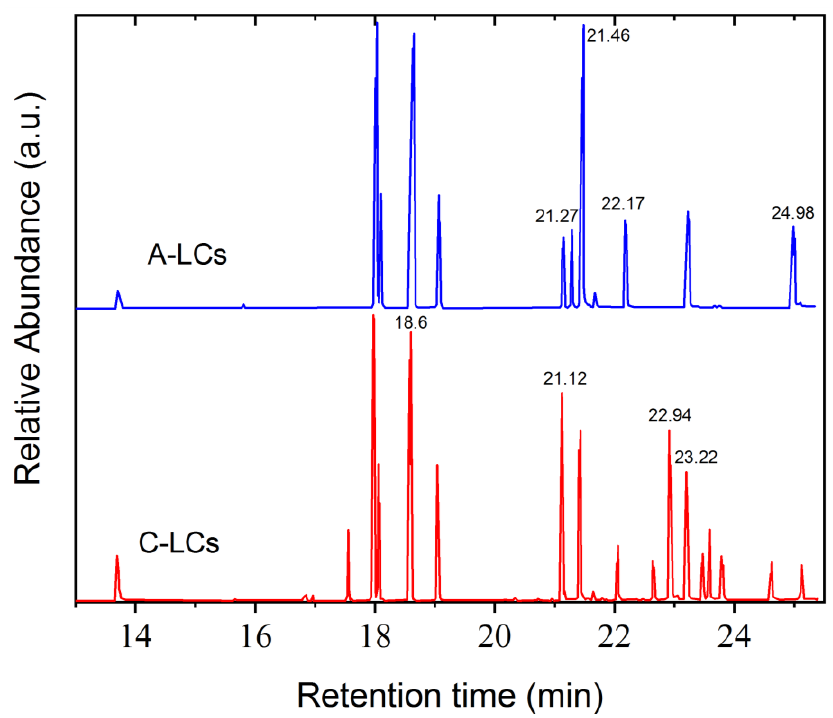
Figure 7. GC results from LC mixtures of EOL-LCD A and C.